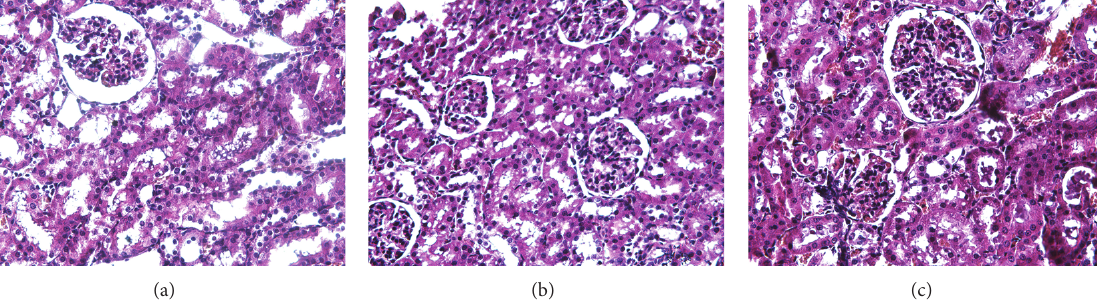
Figure 1: Effects of mesenteric lymph drainage on pathomorphology of kidney in hemorrhagic shock rats without resuscitation (HE staining, ×500 ). (a) Sham group; (b) shock group; (c) drainage group.